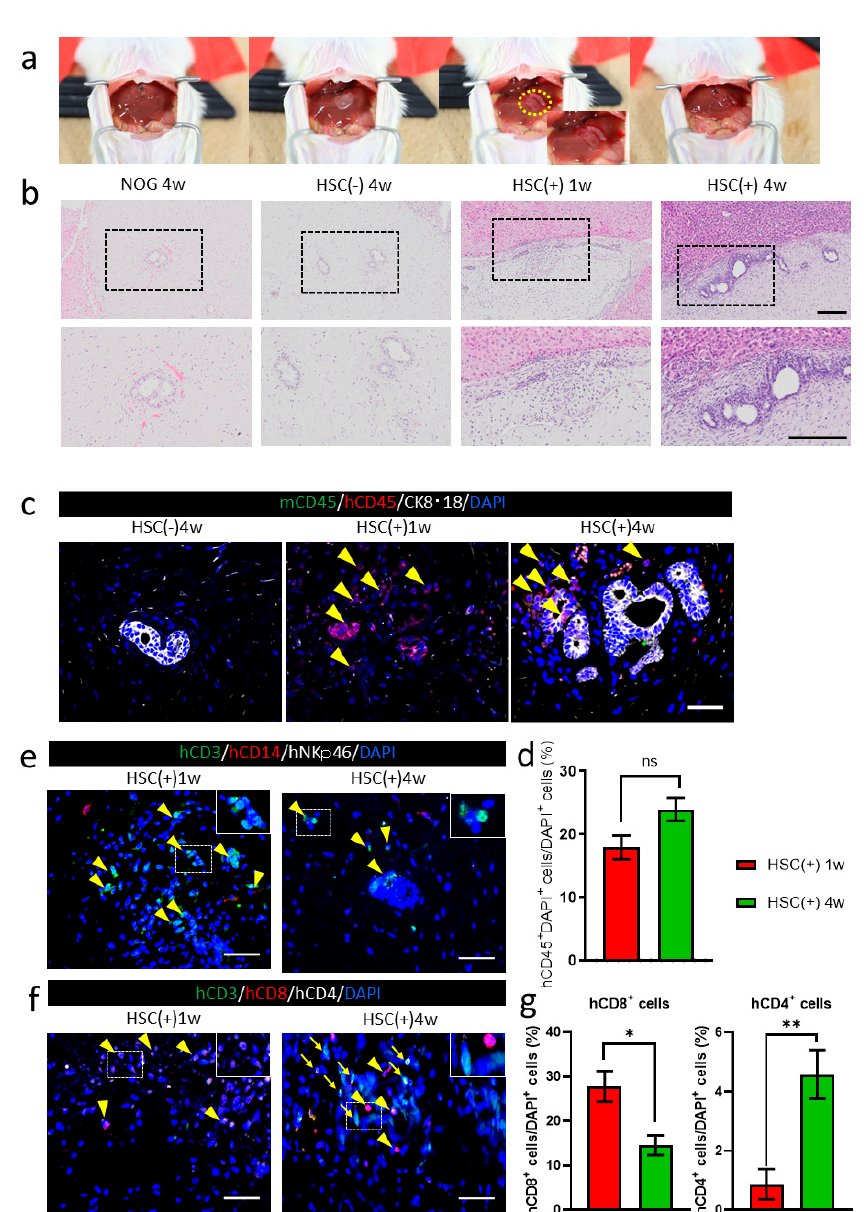
Figure 3. hiPSC-derived liver bud transplantations in NOG-HLA-A2Tg mice. ( a ) The image depicts the transplantation procedure. The yellow circle is the position where the liver bud was transplanted. ( b ) Hematoxylin and eosin staining. Top row shows low magnification, and bottom row depicts a zoomed-in image of the black frame border. Scale bar: 200 µ m. ( c ) Immunohistochemistry for human lymphocyte detection: mCD45 (green), hCD45 (red), CK8 · 18 (white), and DAPI (blue). Arrowheads represent hCD45 + cells. Scale bar: 50 µ m. ( d ) Count of the hCD45 + cells ratio. Error bar: SEM, Mann–Whitney U test, ns: no significance, HSC(+) 1w n = 18, and HSC( + ) 4w n = 31. ( e ) Immunohistochemistry for T-cell detection is shown: hCD3 (green), hCD14 (red), hNKp46 (white), and DAPI (blue). Arrowheads show hCD3 + cells. Scale bar: 50 µ m. ( f ) Immunohistochemistry for T-cell variation detection: hCD3 (green), hCD8 (red), hCD4 (white), and DAPI (blue). Arrowheads demonstrate hCD3 + hCD8 + cells, and arrows show hCD3 + hCD4 + cells. Scale bar: 50 µ m. ( g ) Count of the hCD8 + cell and hCD4 + cell ratio. Error bar: SEM, Mann–Whitney U test, ns, * p < 0.01 and ** p < 0.0001, HSC(+) 1w n = 15, and HSC( + ) 4w n =